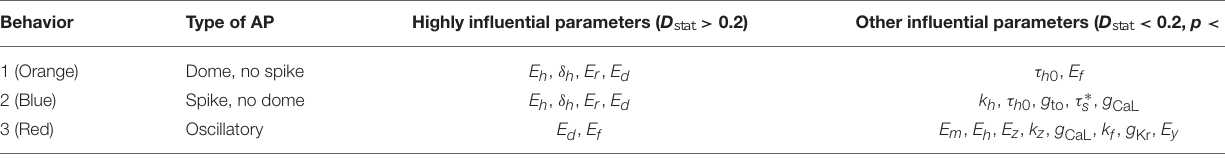
TABLE 2 | Influential parameters for each of the three new behaviors observed in ˆ σ = 5 % results. Behavior Type of AP Highly influential parameters ( D stat > 0.2) Other influential parameters ( D stat < 0.2, p < 0.01)